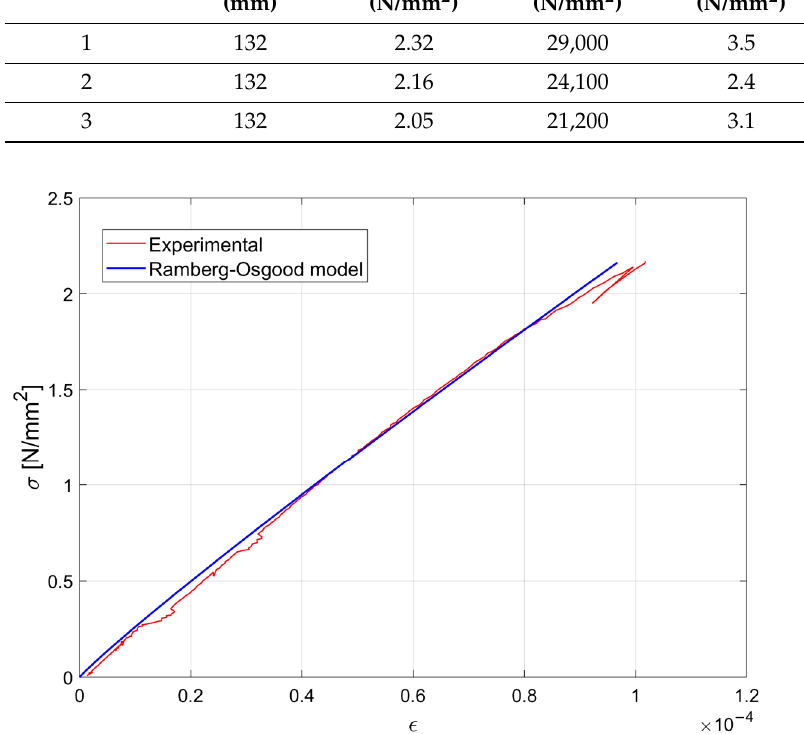
Figure 9. Experimental tensile stress–strain diagram for concrete (specimen n.2 in Table 4).